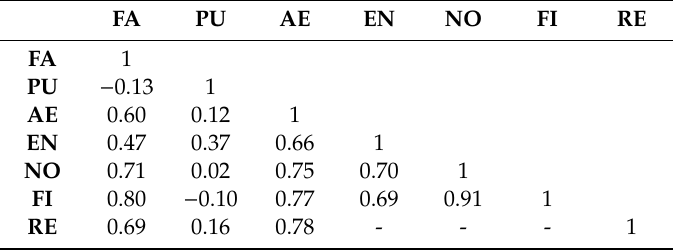
Table 3. Correlation among the six factors.